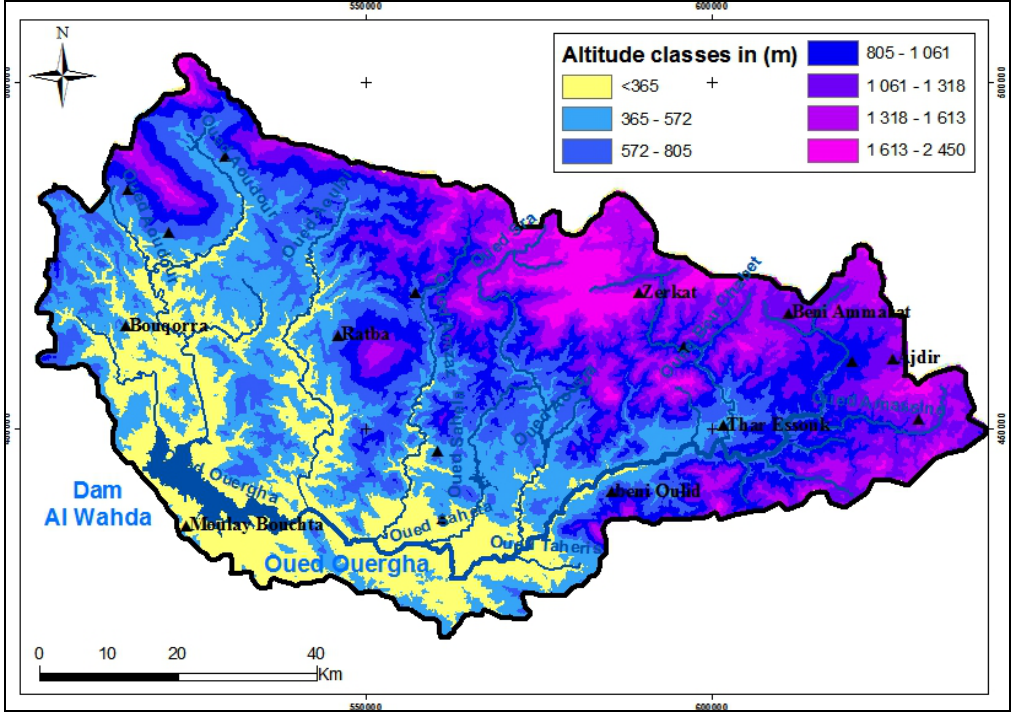
Figure 2 . Map of Altitude Classes of the Ouergha